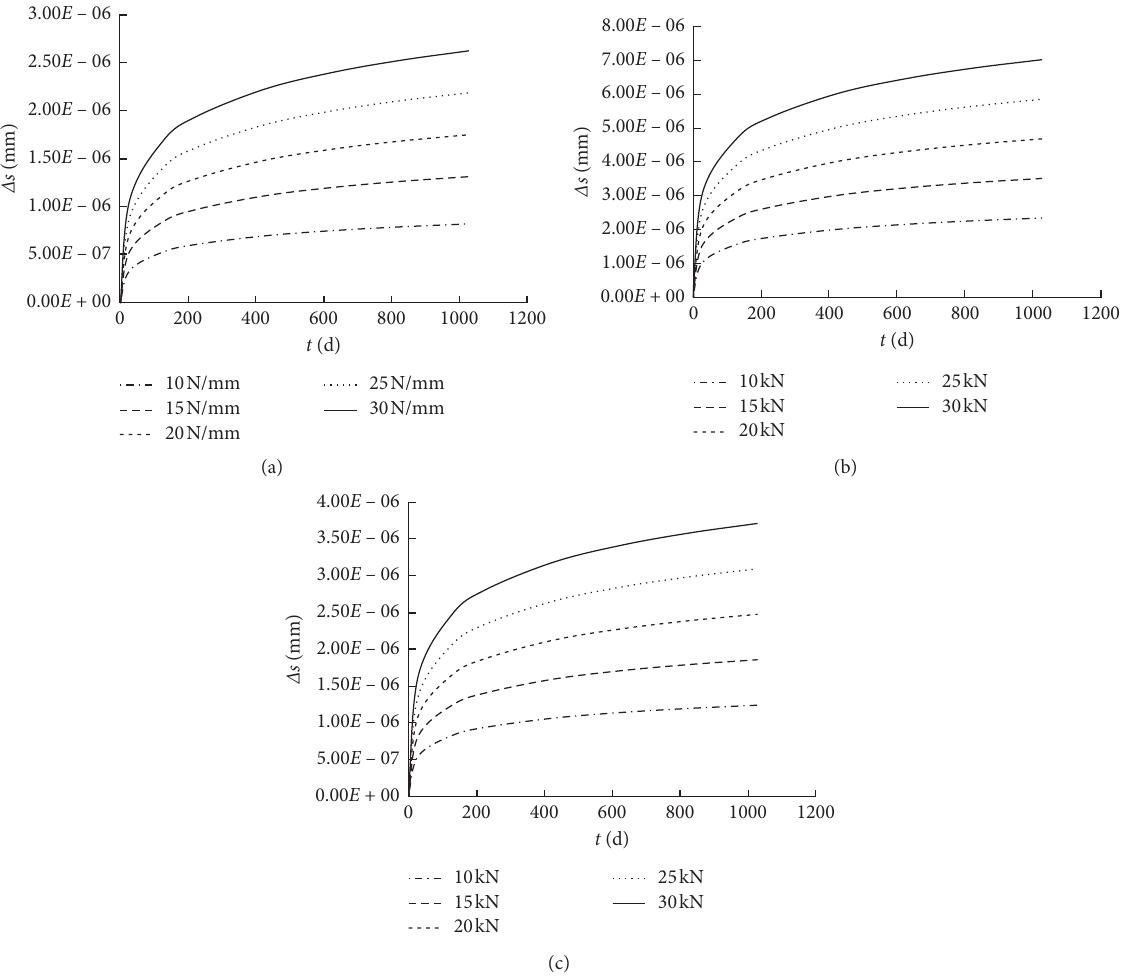
Figure 10: The effect of loading under creep on the interface slip. (a) Uniform load. (b) Symmetrical concentrated load. (c) Midspan concentrated